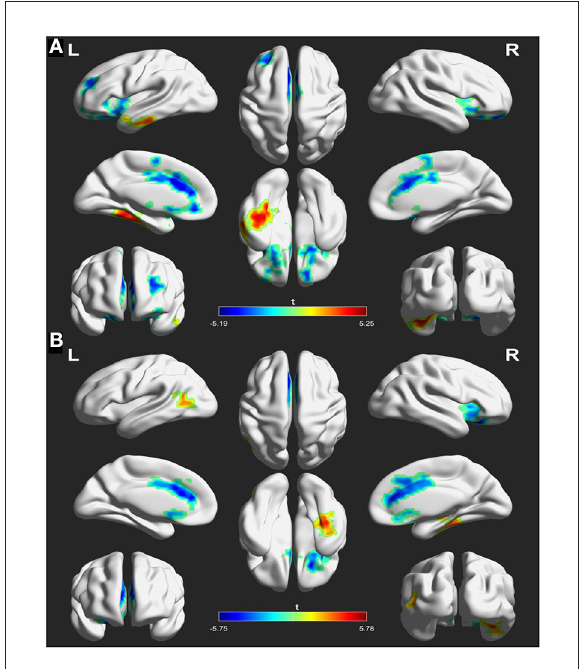
FIGURE2 Differences in functional connectivity (FC) between patients at baseline and healthy controls using left nucleus accumbent (A) and right nucleus accumbent (B) seed regions. The warm color indicates an increased FC of seed with the whole brain and the cool color indicates a decreased FC of seed with the whole brain. The color scale is represented by the t -value of statistically significant clusters with the voxel-level statistical threshold of p < 0.05 and a cluster-level threshold of p < 0.05 corrected for the Gaussian random field (size >